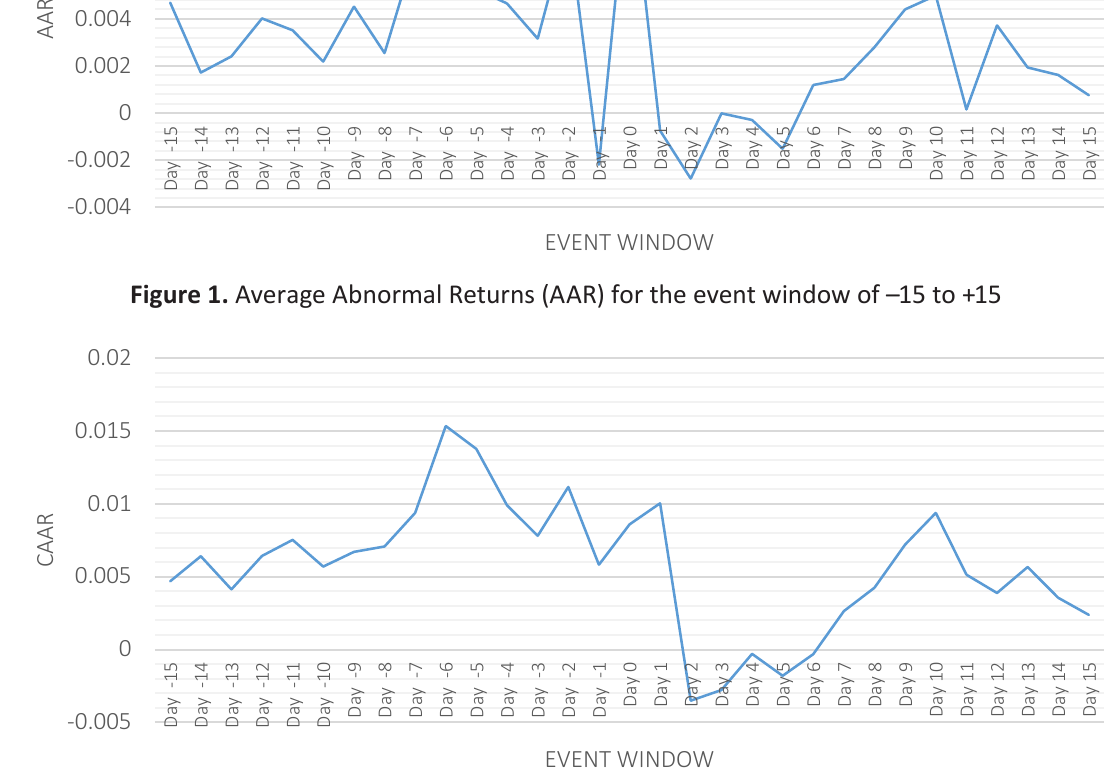
Figure 2. Cumulative Average Abnormal Returns (CAAR) for the event window of –15 to +15